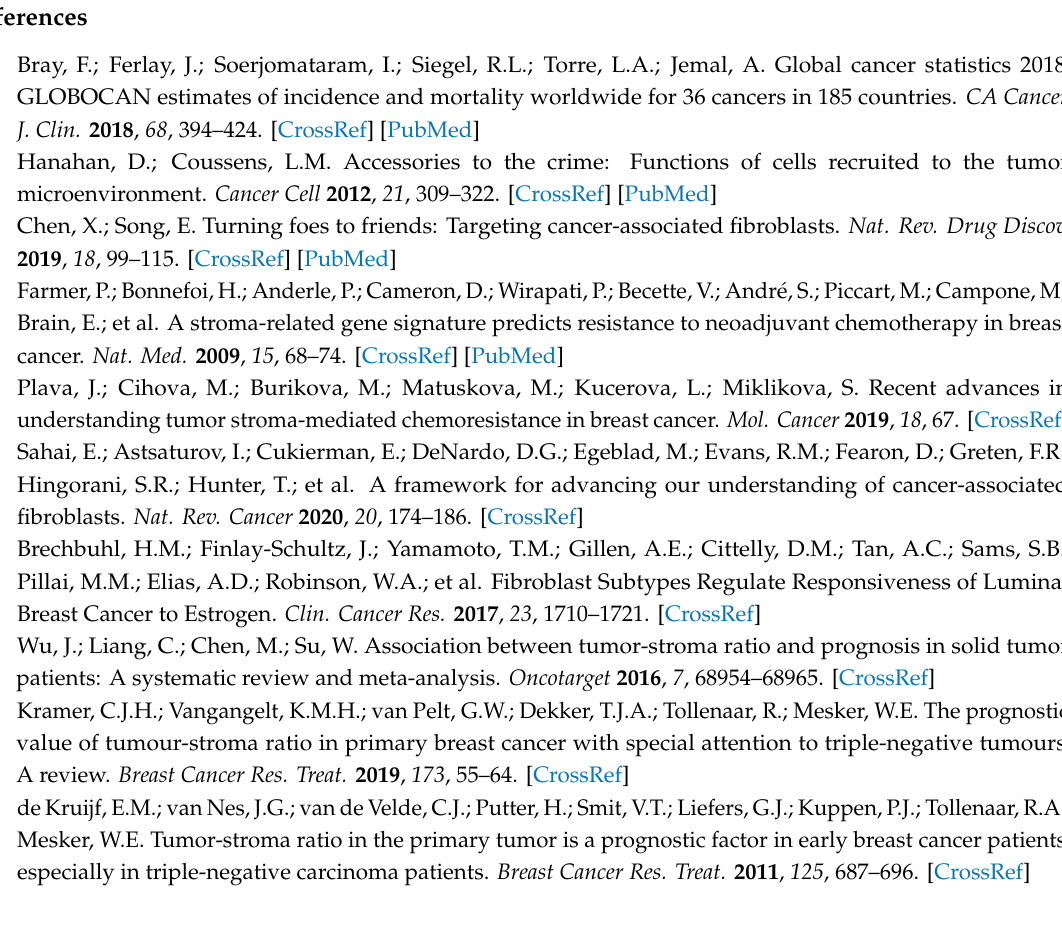
Figure S1: The distribution of tumour stroma ratios within the study cohorts, Table S1: Association of tumour stroma ratio (TSR) with clinico-pathological variables using the X 2 test. * TILs cut point ≤ 30% for TNBC and ≤ 10% for luminal. Meta: metaplastic carcinoma, Table S2: Univariate and multivariate analysis for OS and BCSS in